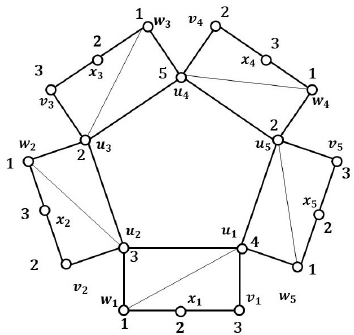
Figure 2. A subdivision of an origami graph O ∗